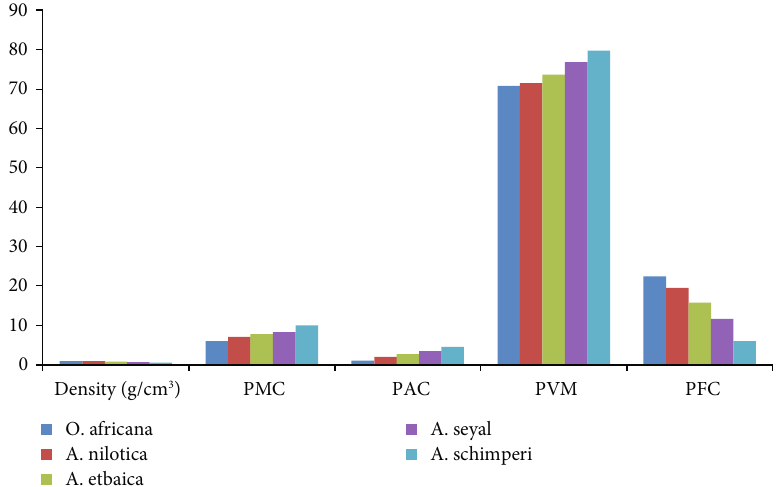
Figure 1: The energy properties of the preferred tree